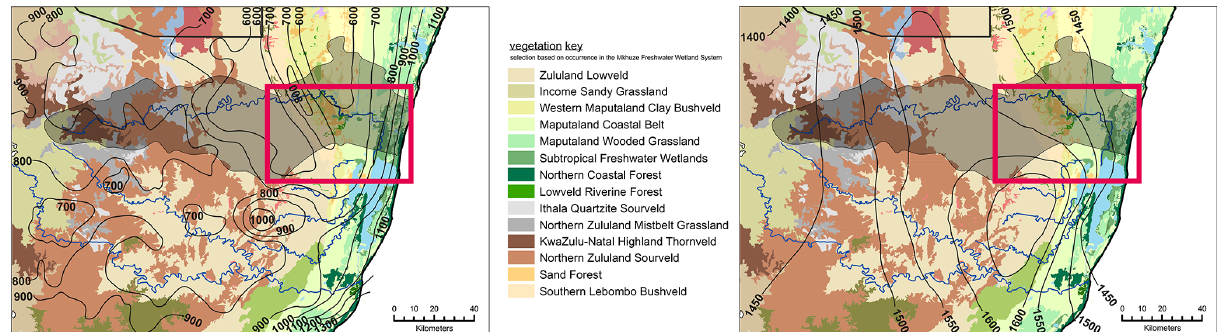
Figure 2. The vegetation coverage in the surroundings of the Mkhuze Wetland System is shown. The figure displays the entire catchment area of the Mkhuze River (represented by the outlined, lightened area). The red rectangle indicates the extent of the study area (see Fig. 1). In addition to vegetation cover, precipitation isolines (left figure) and evaporation isolines (right figure, in mmyr − 1 ) are overlaid (adopted from Taylor, 1982a).